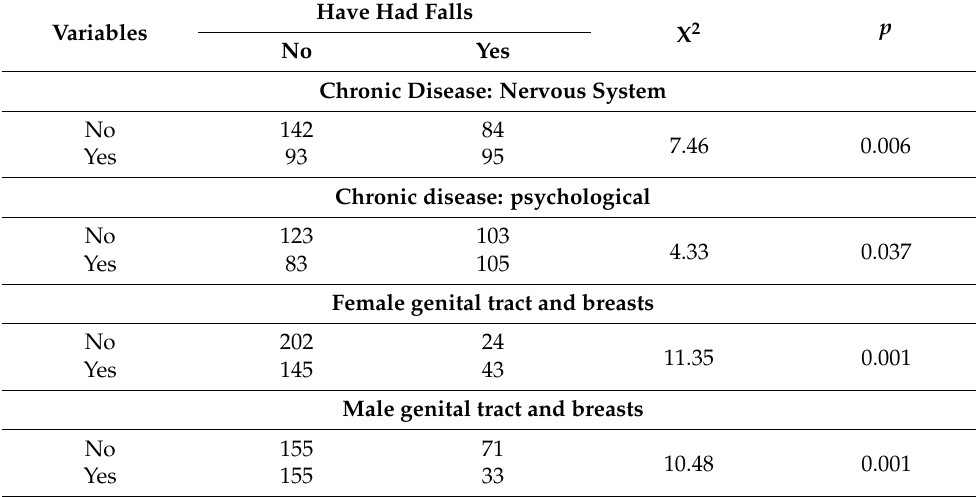
Table 6. Relationship between having had falls and the presence of chronic disorders.